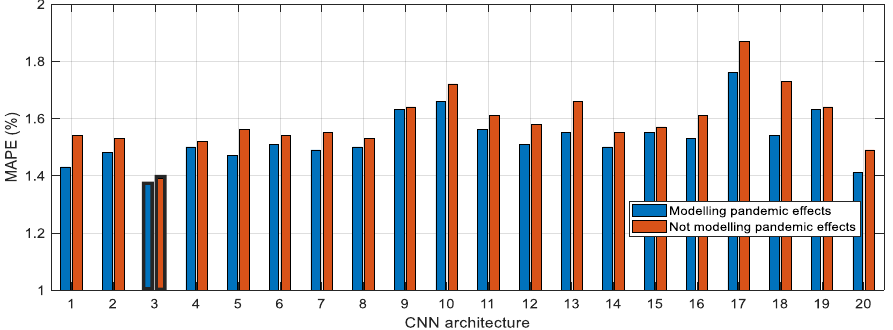
Figure 6. Comparison of results for considered Convolutional Neural Network (CNN) architectures.